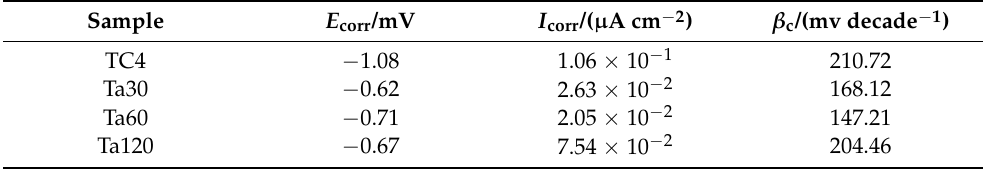
Figure 6. The Potentiodynamic polarization curves of Ta coatings in DMEM at 37 ◦ C. Mirror polished TC4 was used as control. Table 2. Electrochemical parameters of Ta coatings with different alloying time. The tests were conducted in a DMEM solution at 37 ◦